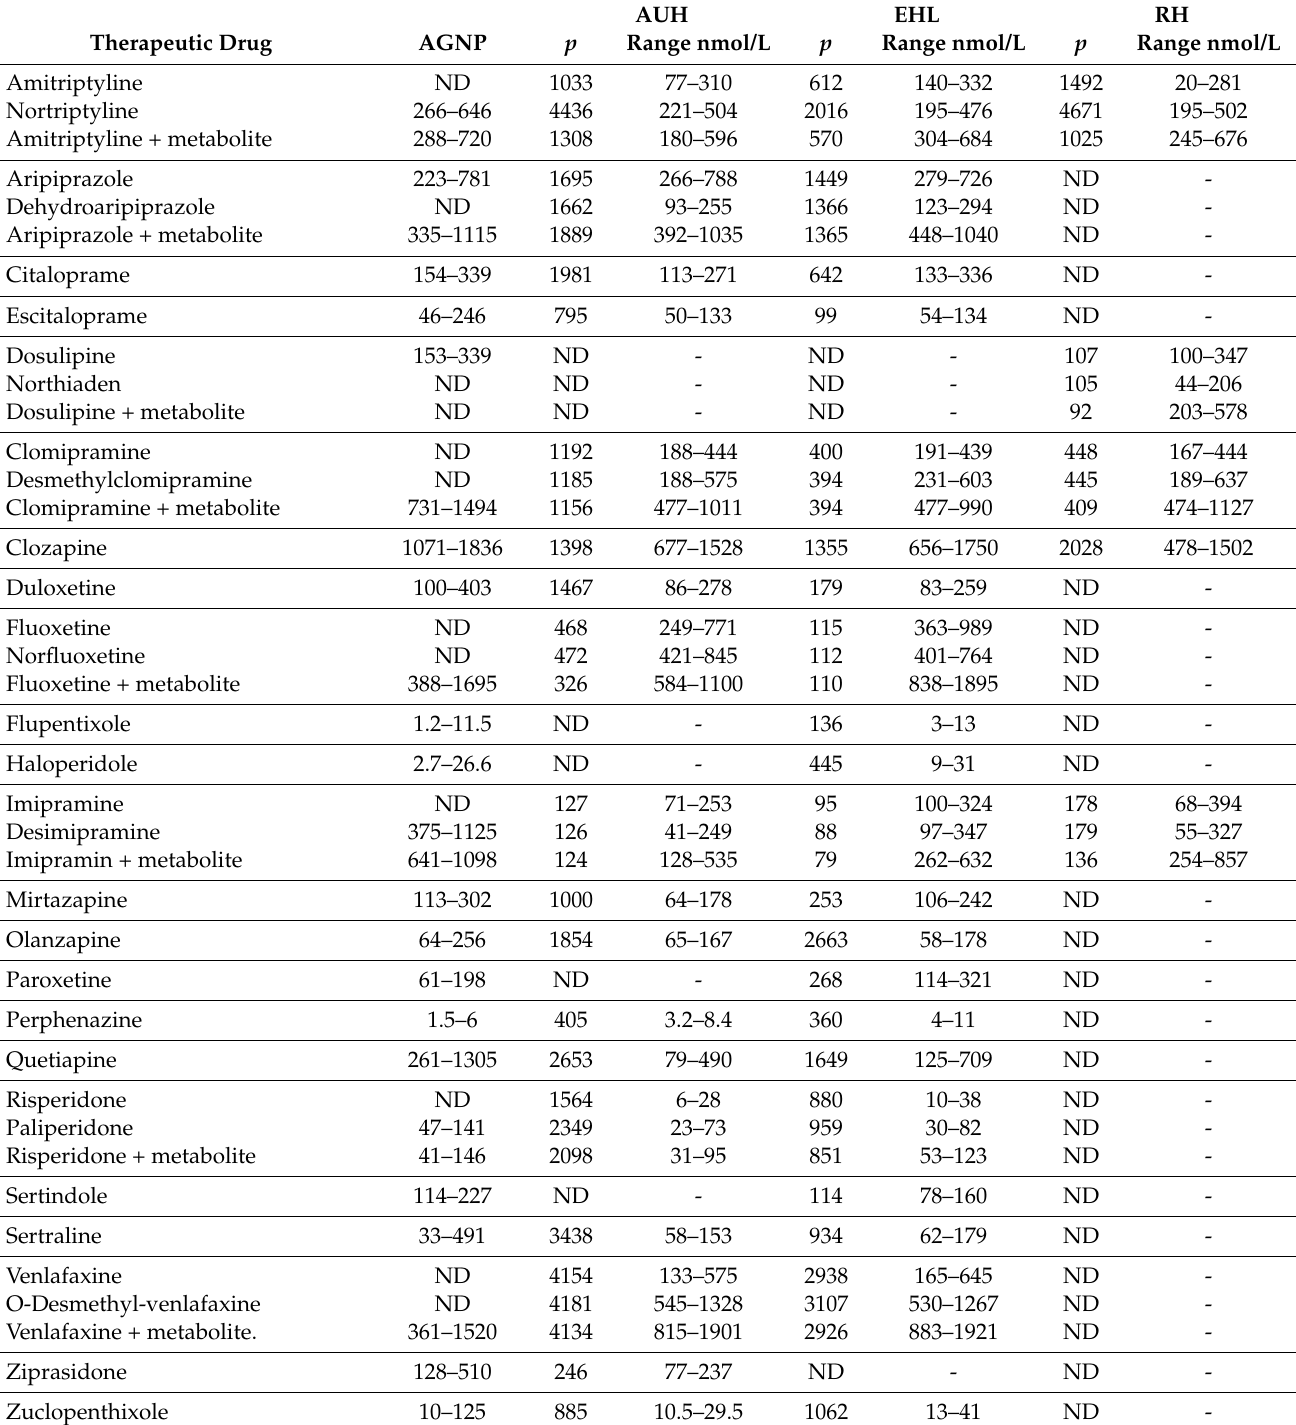
Table 3. Comparison of calculated 25–75 percentiles between the participating laboratories and to the therapeutic reference ranges published in the AGNP consensus guideline. For abbreviations, see Table 2. Additional statistics is in supplementary File Table